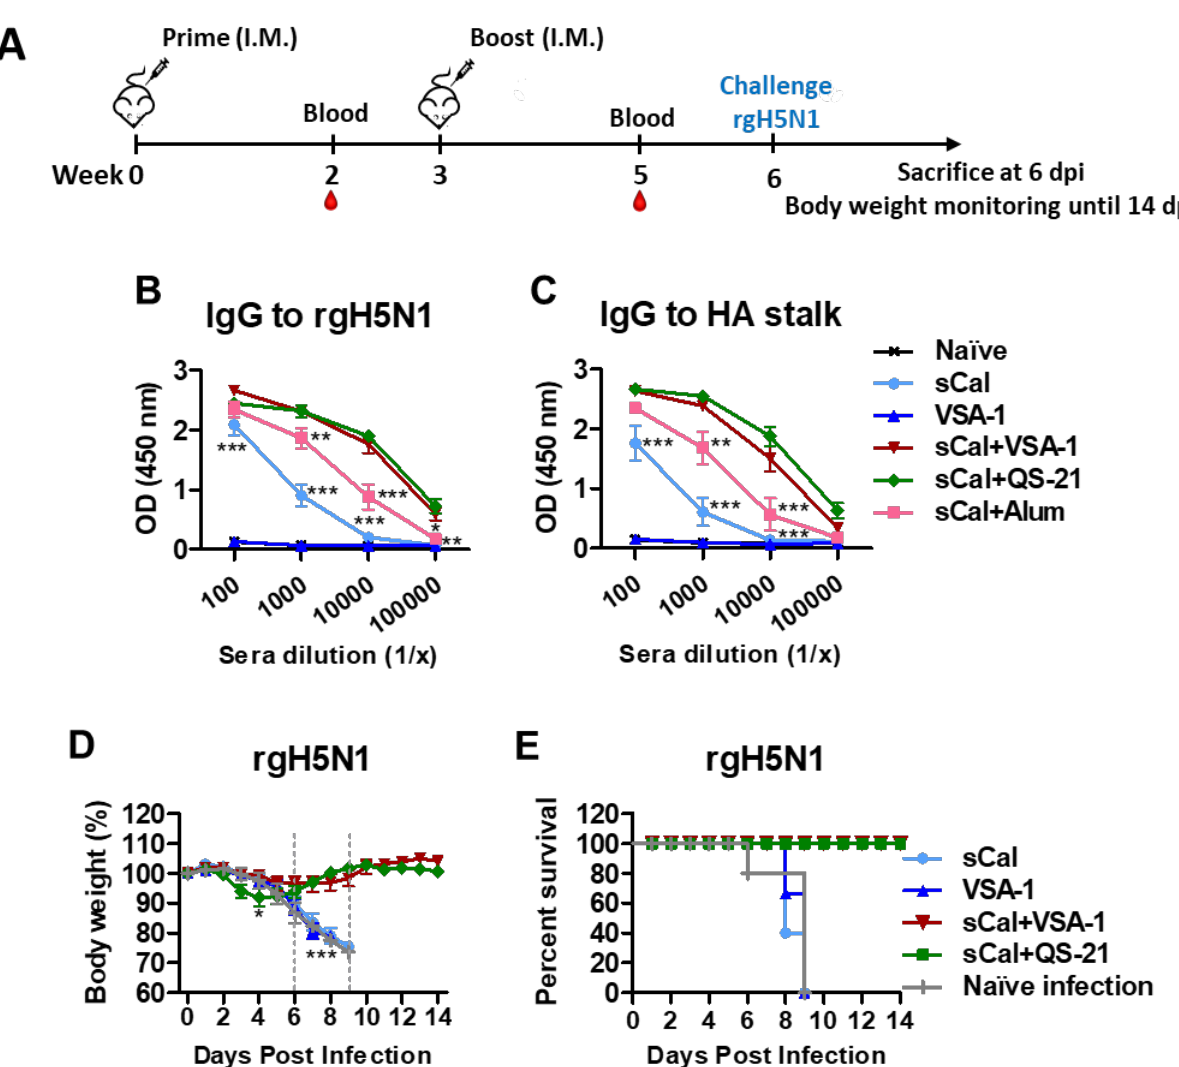
Figure 6. VSA-1-adjuvanted prime-boost sCal vaccination confers protection against lethal infection with heterosubtypic rgH5N1 virus. ( A ) Immunization and virus challenge scheme ( n = 7). ( B ) rgH5N1 virus-specific IgG antibody levels in boost sera. ( C ) HA2 stalk-specific IgG antibody levels in boost sera. ( D ) Body weight changes and ( E ) survival rates after challenge with a lethal dose of rgH5N1 virus (3 × LD 50 ) for n = 4 per group. Error bars indicate the mean ± SEM. *; p < 0.05, **; p < 0.01, ***; p < 0.001 compared to the sCal + VSA-1 group.